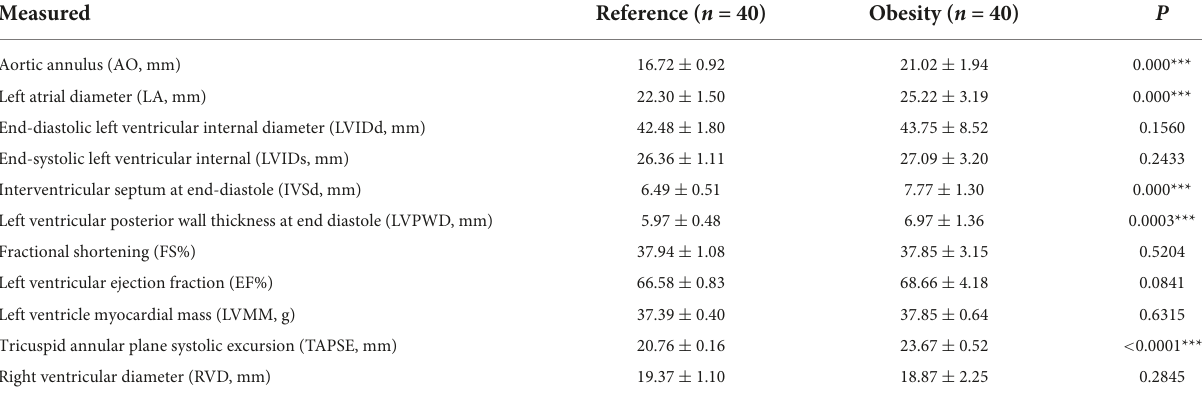
TABLE 7 Left and right ventricular function